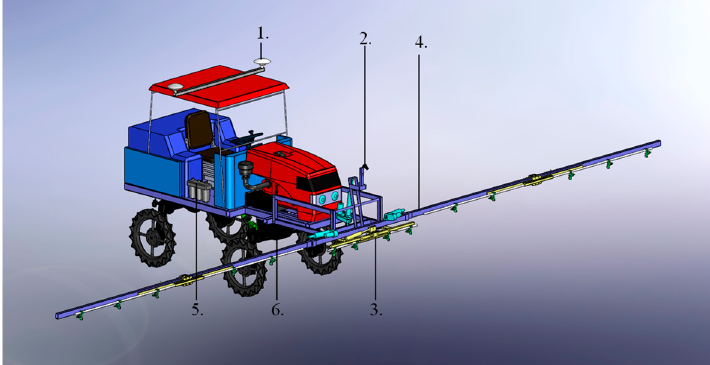
Figure 1. Structure of the visual row-oriented spraying platform: 1. Navigation system 2. Vision system 3. Row-oriented control system 4. Sliding boomer 5. Application supply system 6. Travel chassis.